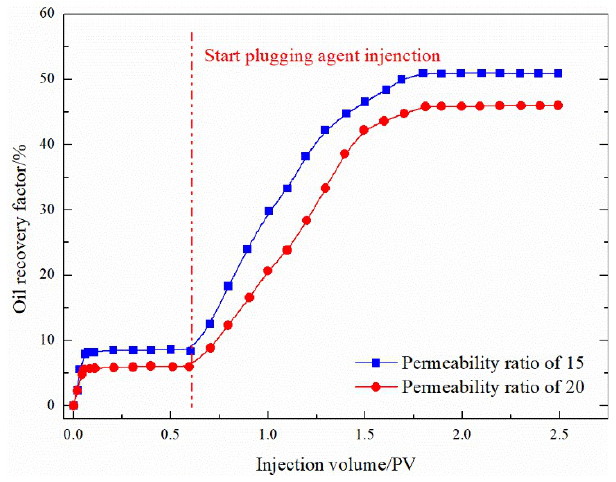
Figure 14. EOR experiment with a permeability ratio of 15 and 20.